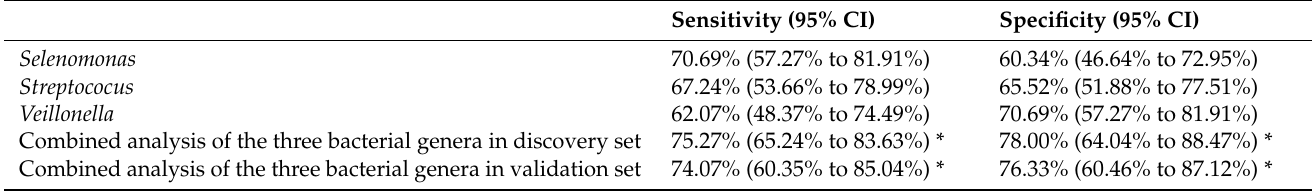
Table 2. Diagnostic performance of bacterial genera in